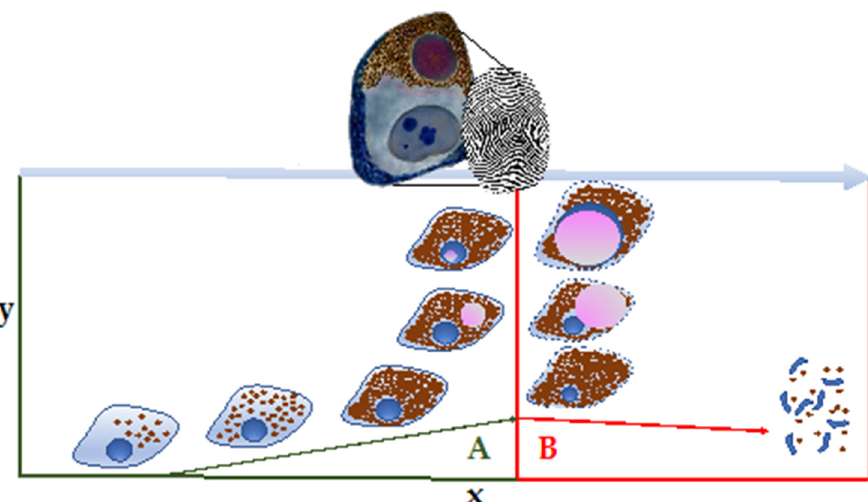
Figure 3. Intranuclear and intracytoplasmic inclusions in NM-containing neurons exhibit a specific fingerprint-like pattern of the real status of some neurons. In “A”, neurons are still healthy, while in “B”, they are proceeding toward death with the activation of microglial (rod) cells and eventual neuronophagia. The activation of microglia by NM can drive antigen presentation by SN and LC neurons, a response that may represent a critical step in PD pathogenesis. Part of the drawing was adapted from Vila, 2019 [39] .